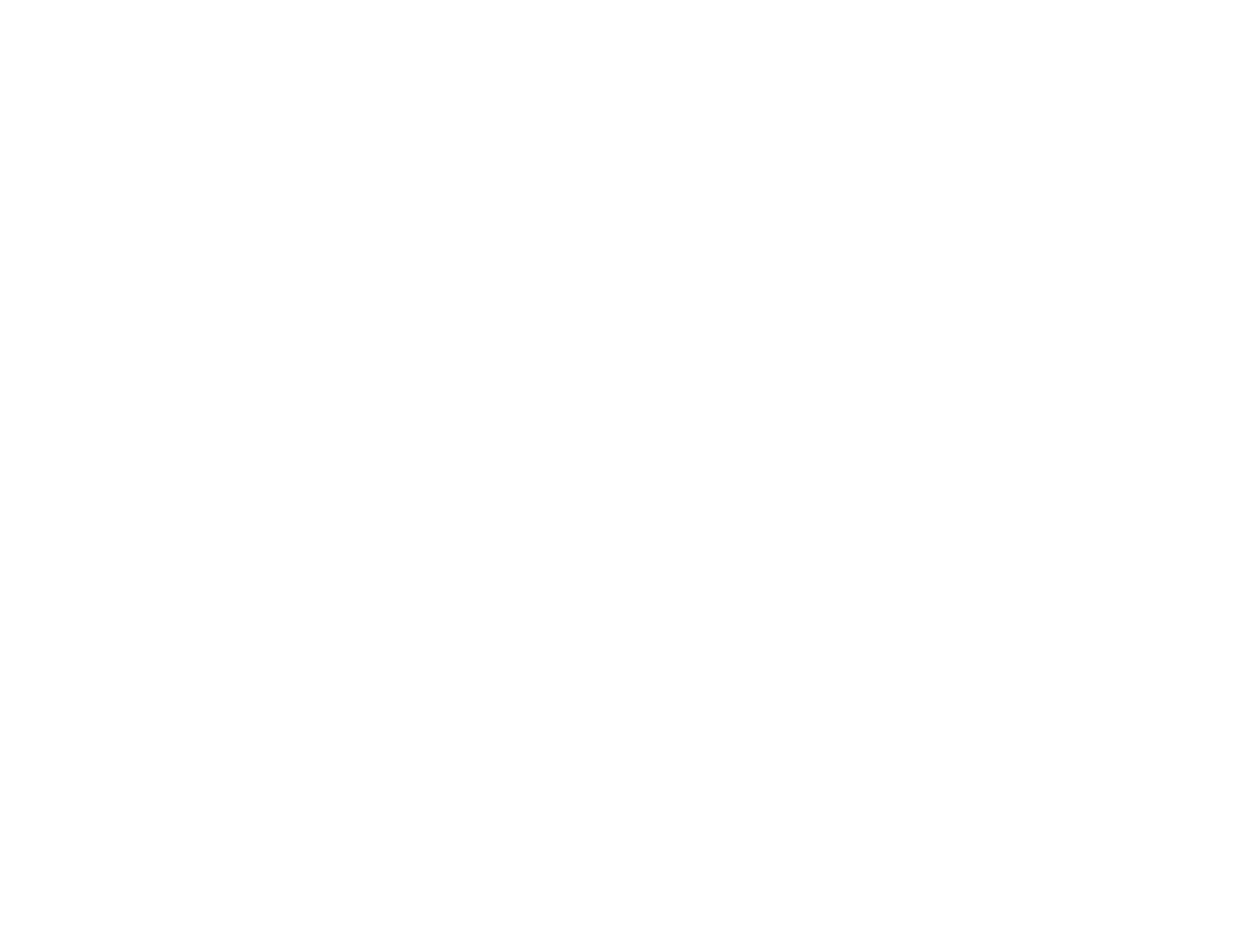
standard deviation is comparable between the different type of normalizations. Rpn, reference protein normalization; if, label free normalization based on fraction of total peptide ion sum; nonorm, no normalization was